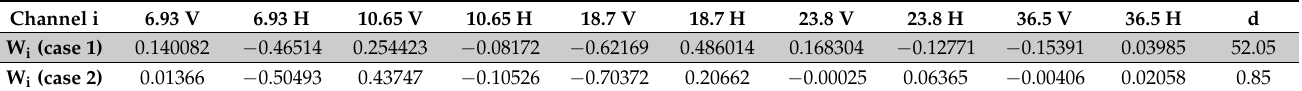
Table 2. Values of the components of the Fisher Linear Discriminant Analysis projection vector W (Appendix A) within the 10-dimensional space spanned by the AMSR2 TB channels in the training data set (Table 1). The length of the vector W has been normalized to 1. Case 1 refers to the algorithm using the AMSR2 TOA as input. Case 2 refers to the algorithm using the AMSR2 measured minus expected specular surface emissivities as input. The last column contains the values for the decision boundary d for each case.